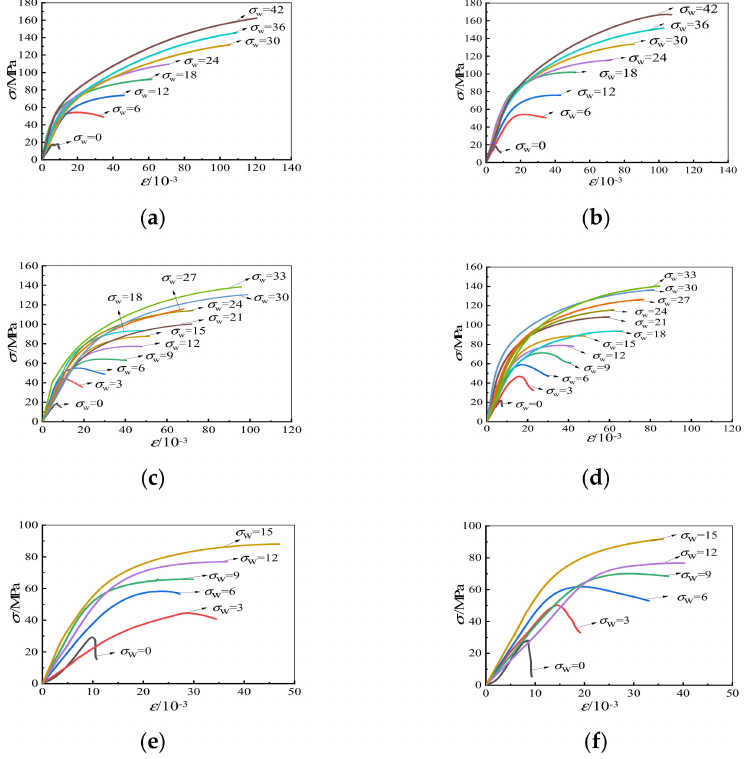
Figure 6. The stress-strain curves. ( a ) LAC20, Soak for 1 h, ( b ) LAC20, Soak for 12 h, ( c ) LAC30, Soak for 1 h, ( d ) LAC30, Soak for 12 h, ( e ) LAC40, Soak for 1 h, ( f ) LAC40, Soak for 12